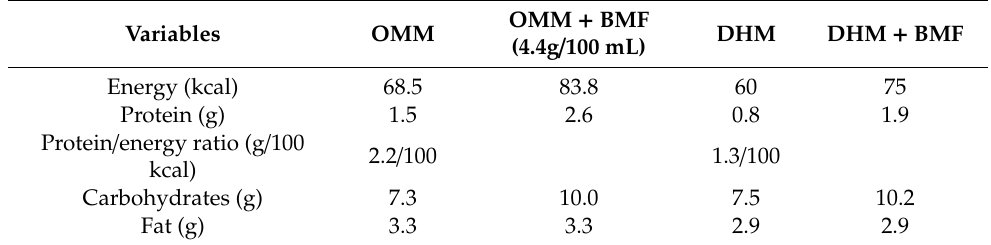
Table 1. Reference values used for the nutritional composition of human milk per 100 mL.